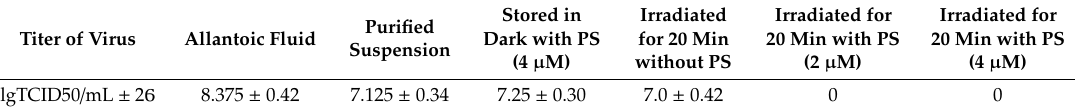
Table 1. Determination of virus titers by virus titration on Madin Darby Canine Kidney (MDCK) cells. It has been shown that 20 min irradiation with photosensitizer (PS) leads to the total inactivation of the